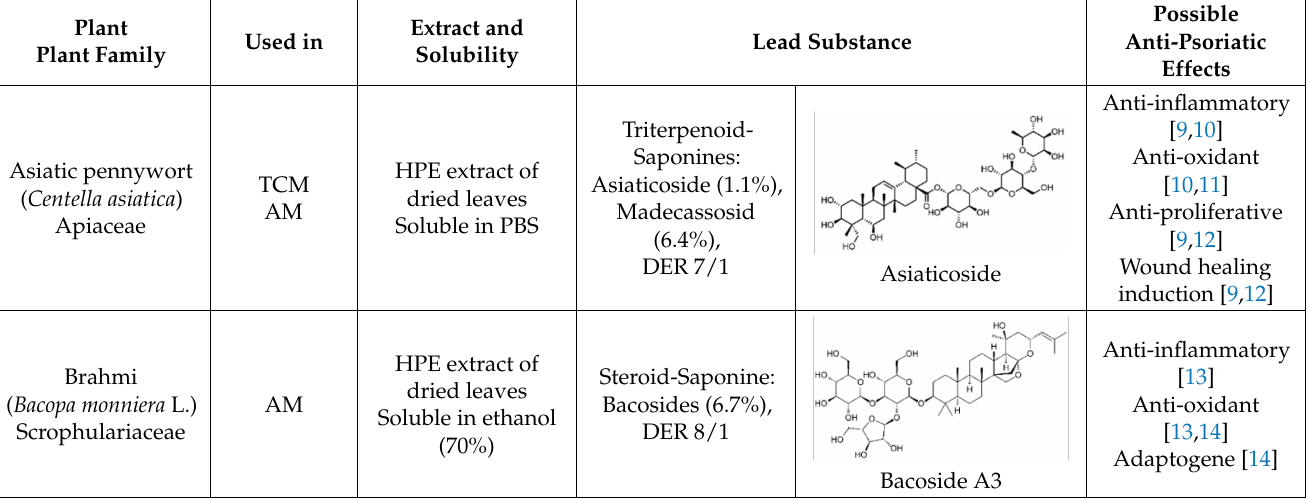
Table 1. Characterization of 10 plant extracts used in folk medicines with their lead substances and dithranol as a control. Plant Plant